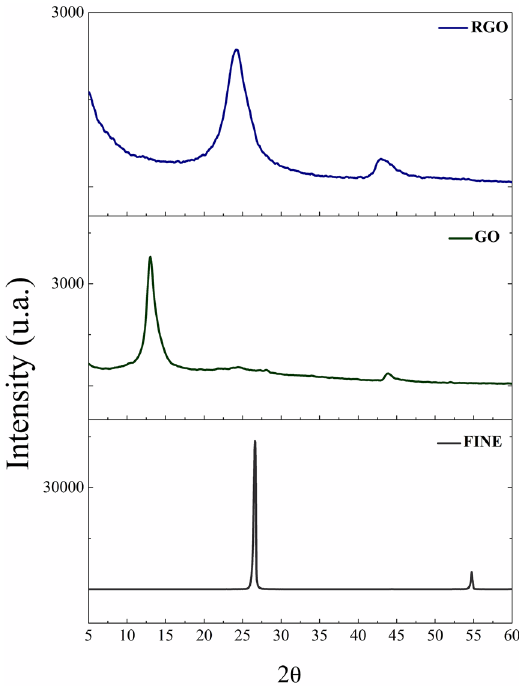
Figure 2. XRD patterns of FINE, GO and RGO.